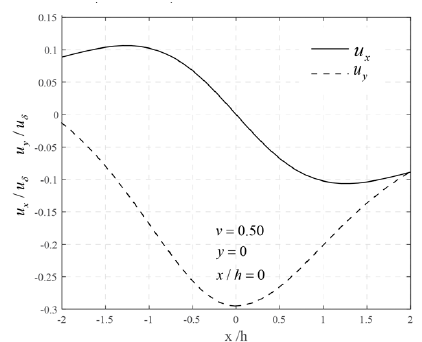
Figure 14. Approximate solution on the slope for 𝑅/ℎ =0.5, 𝑥/ℎ = 0 𝑣 = 0.50 , −0 .09  𝑢 𝑥  0.09.